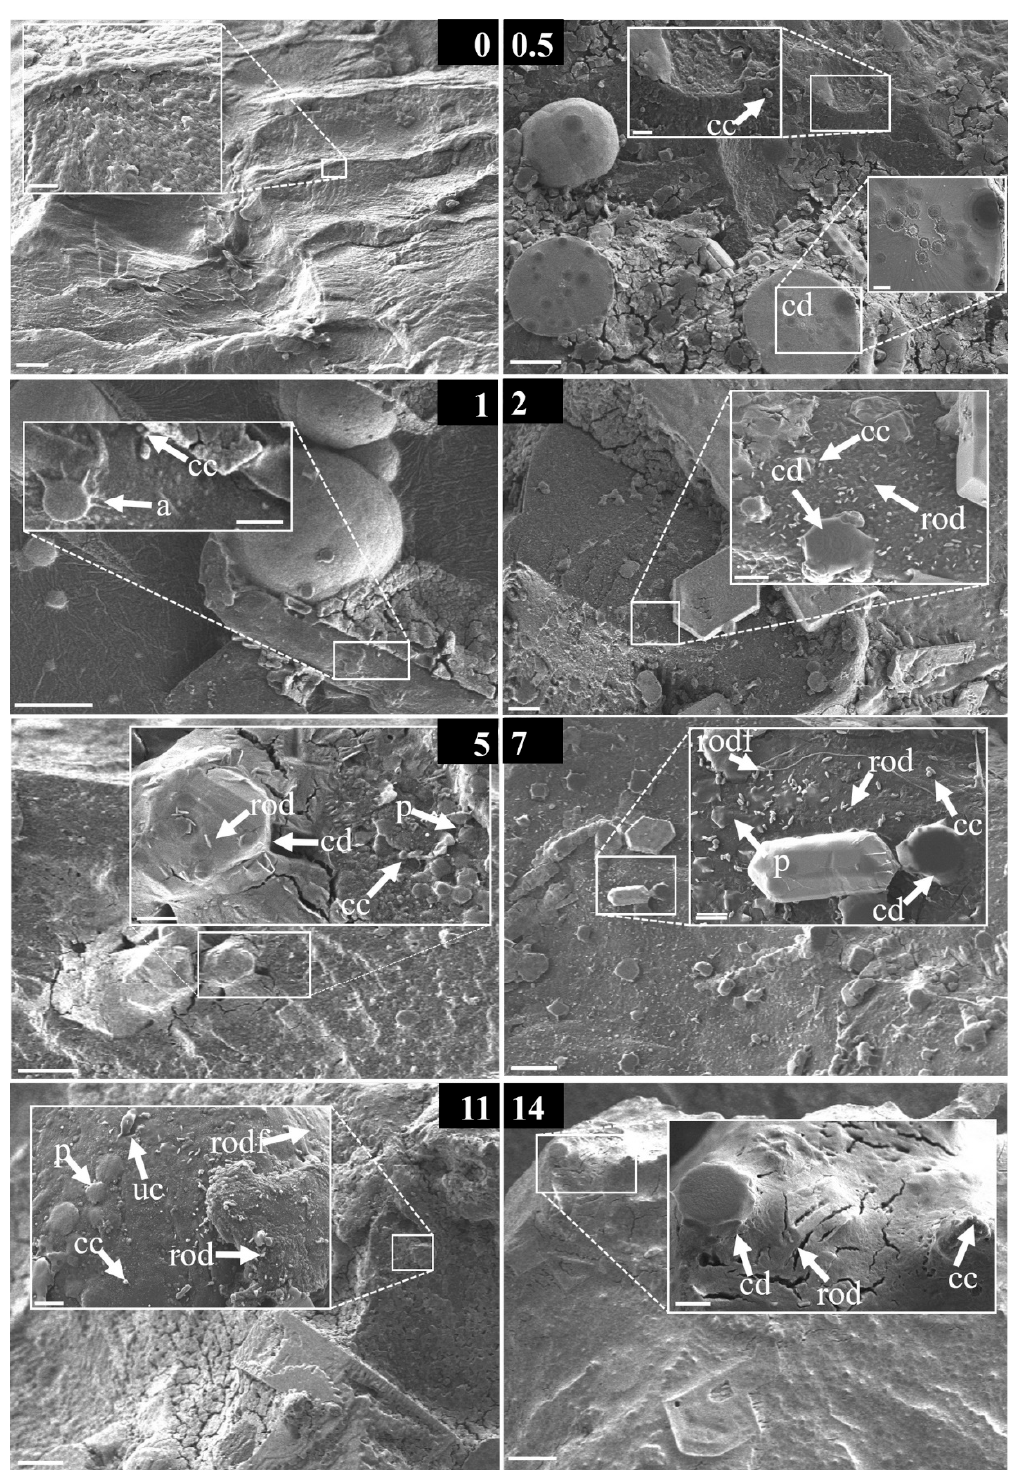
Figure 5. Scanning electron microscopy images of PA incubated in seawater. Numbers in black boxes indicate incubation times in days (0 = raw material, 0.5 = half day, 1 = one day, 2 = two days, 5 = five days, 7 = seven days, 11 = eleven days, 14 = 14 days of incubation). Microorganismal structures are highlighted with arrows. a = non-assignable structure, rod = rod- / vibrio-shaped bacteria, rodf = rod- / vibrio-shaped bacteria with long flagella, cc = coccoid bacteria, cd = centric diatom, p = platelet structure, uc = unicellular structure. Scale bar: Large image 10 µm, magnified image 2 µm.